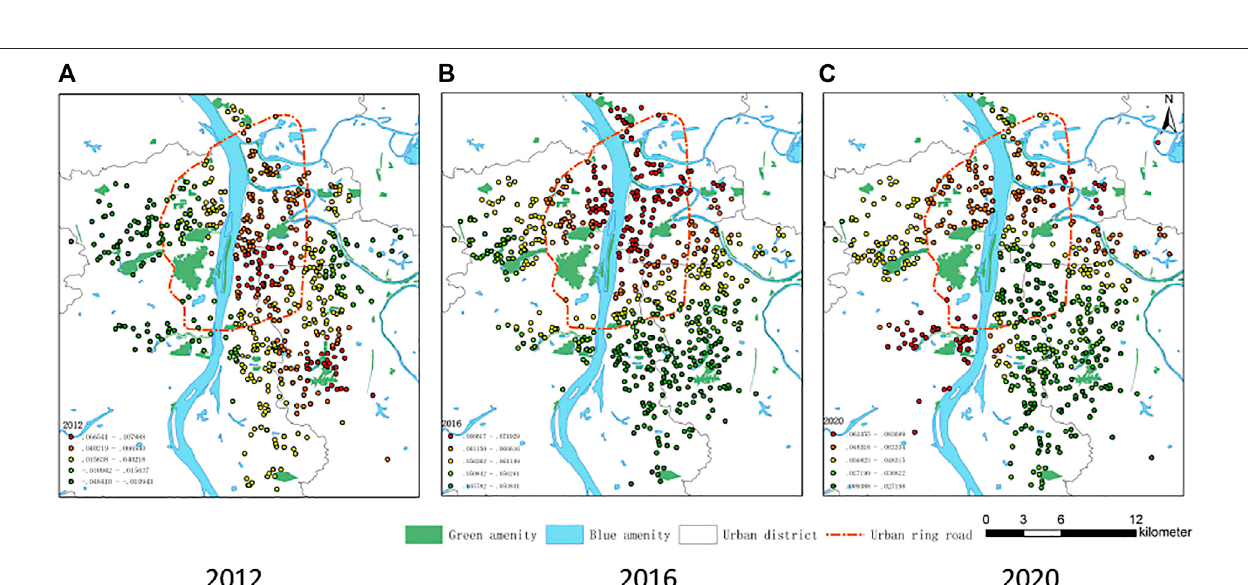
FIGURE 8 | Spatial and temporal variation of green ratio in fl uence coef fi cients in 2012,2016 and 2020.